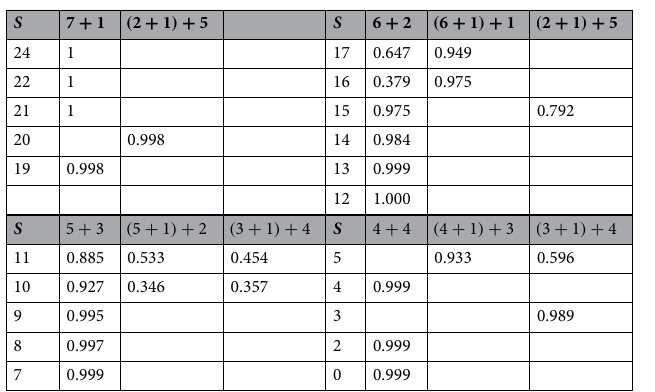
[ N 2 ] ) S | � S ,1 � (( N ′ 1 + 1 ) + N 1 + 1